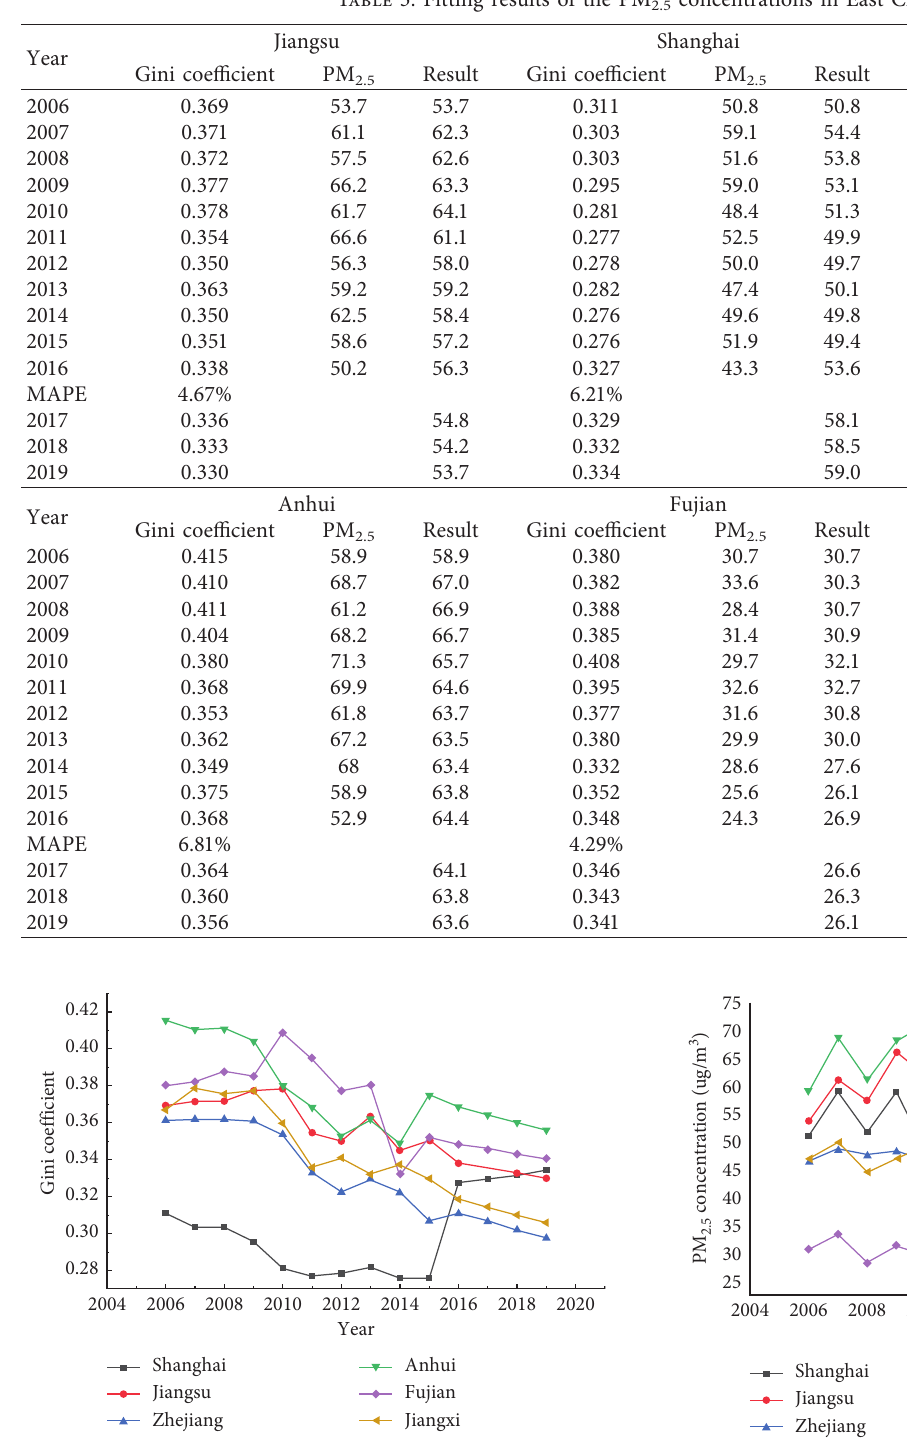
2.5 concentrations in East China.